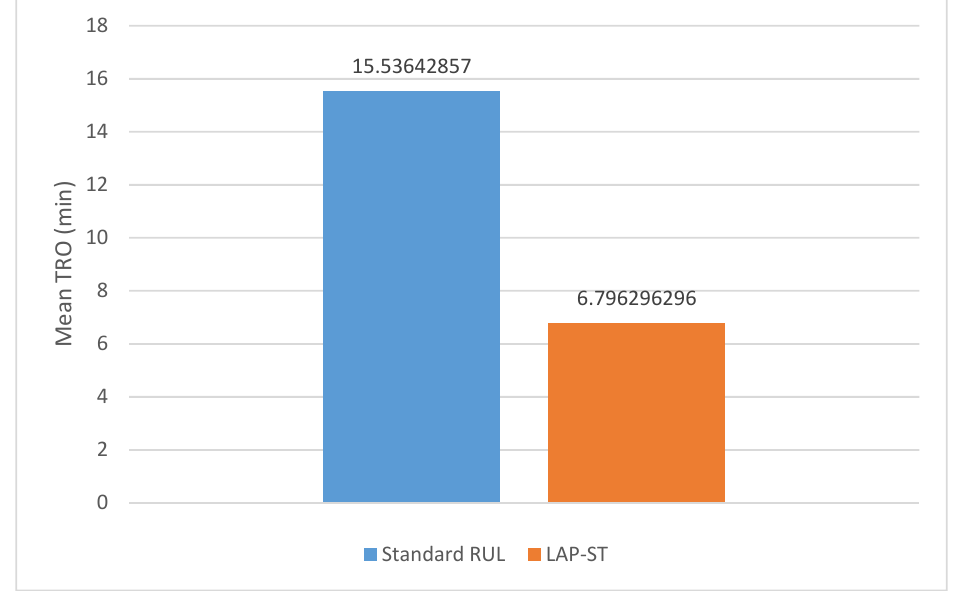
Figure 2. Time to Reorientation (TRO) for LAP-ST compared to UB-RUL-ECT: Mean TRO was much faster in the LAP-ST arm (6.8 min; SE = 4.9) than with standard UB-RUL ECT (15.5 min; SE = 6.5).